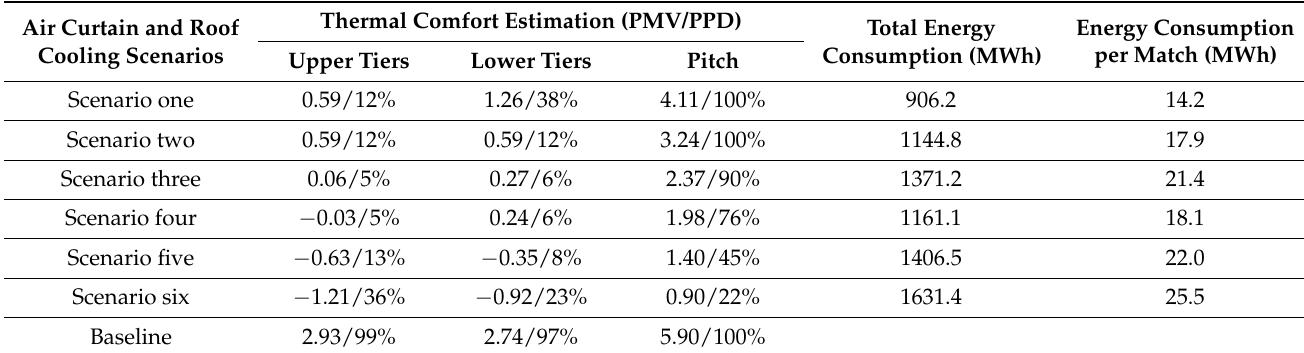
Table 7. Thermal comfort indexes and energy consumption estimations.